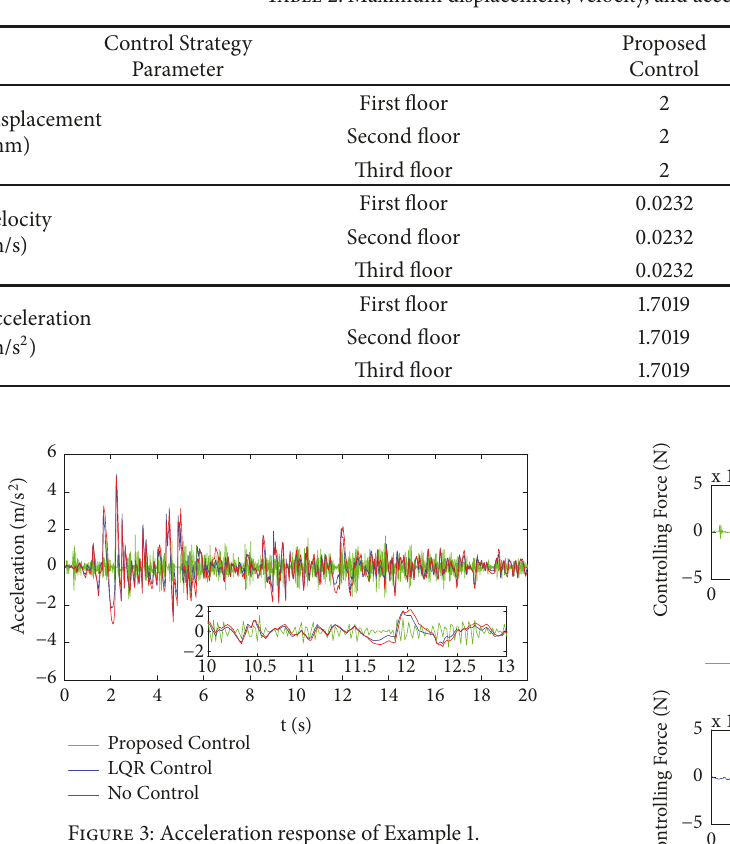
Table 2: Maximum displacement, velocity, and acceleration of Example 2.